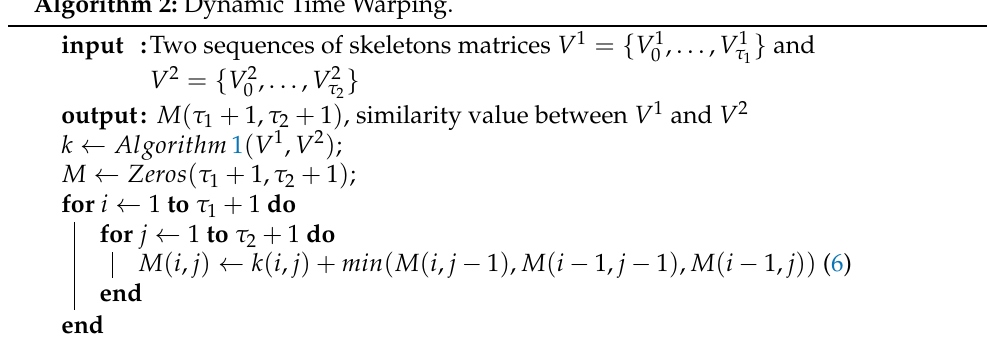
Algorithm 2: Dynamic Time Warping.